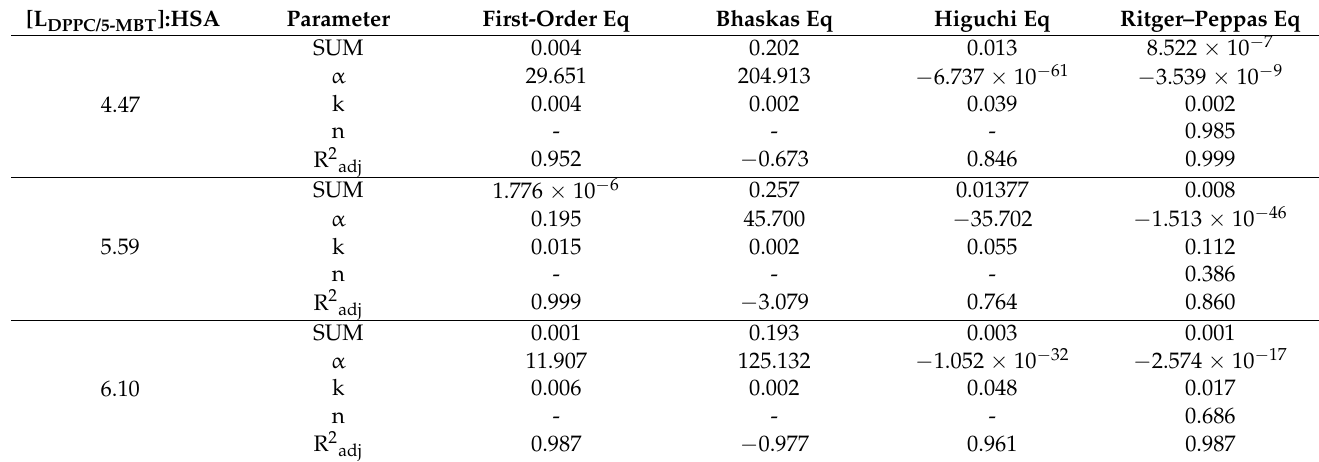
Table 3. Fitting parameters of the 5-MBT release profiles from the [L DPPC/5-MBT ]:HSA complex to different kinetic